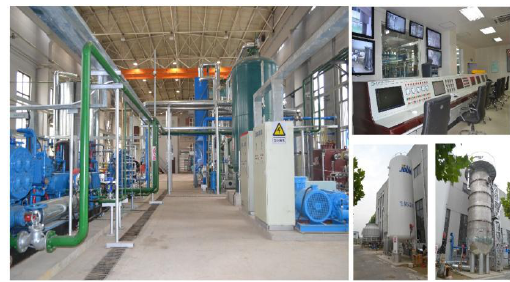
Figure 13. 1.5 MW SC-CAES pilot plant in China [60].